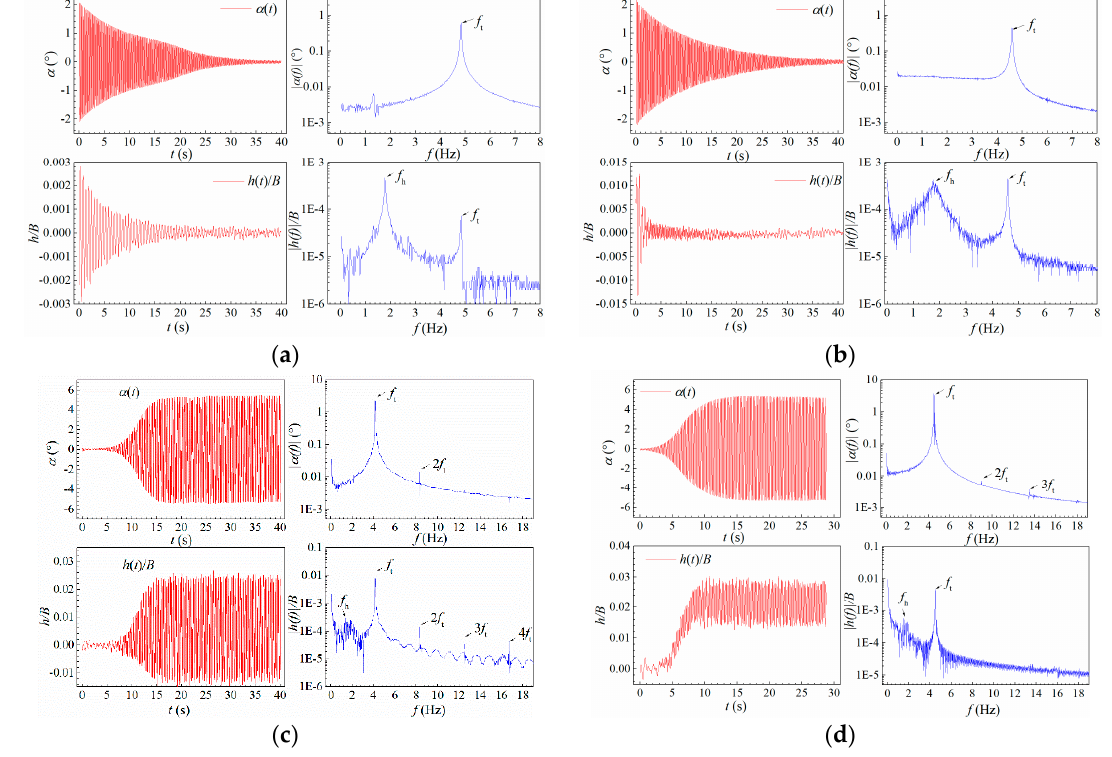
Figure 6. Typical vibration responses under different reduced wind speed. ( a ) Case B1, U * = 0.855; ( b ) Case B1, U * = 4.835; ( c ) Case B1, U * = 7.785; ( d ) Case A1, U * = 5.365.